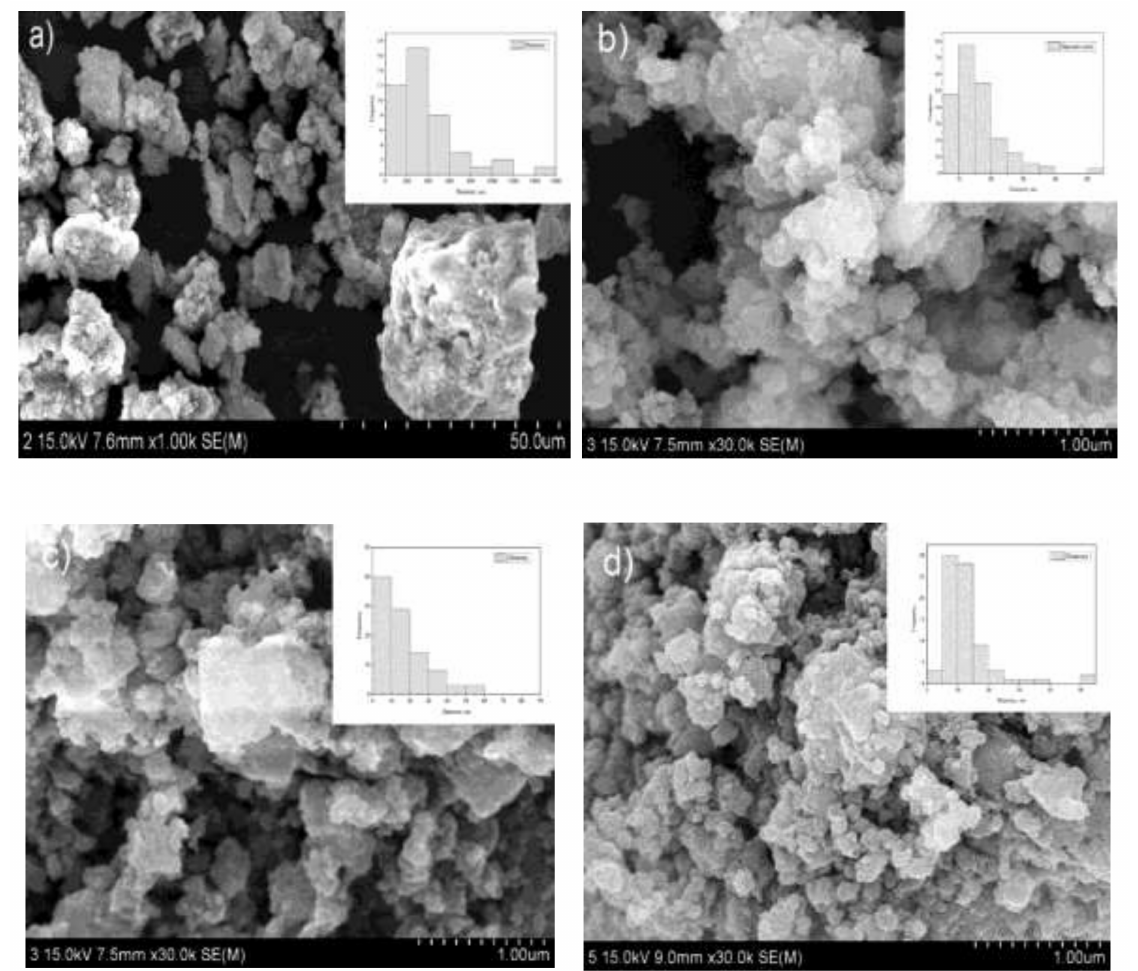
Figure 2. SEM images of mechanically activated black dross: ( a ) as-received; ( b ) milled for 1 h; ( c ) milled for 3 h; ( d ) milled for 7 h. (Milling speed: 400